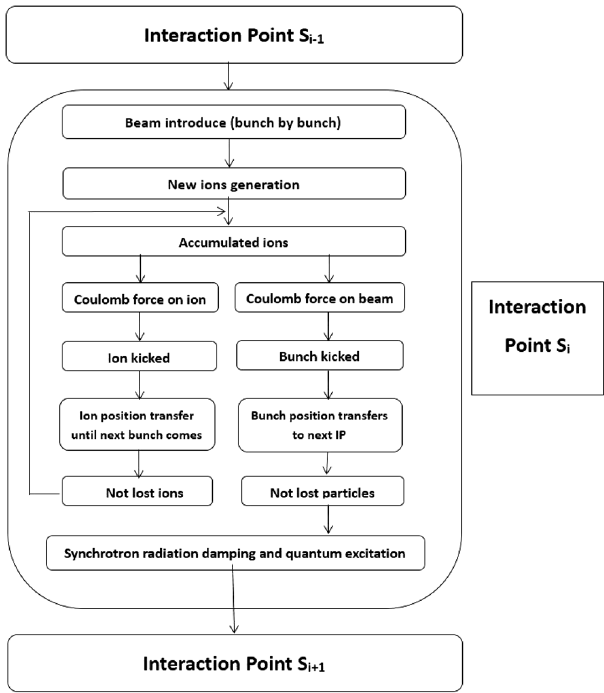
FIG. 1. Logic flow of the beam-ion interaction in simulation at the interaction points S i . The ion generation, beam-ion inter- action, beam and ion loss assertion, effects of synchrotron radiation, quantum excitation, and beam transportation are sequentially